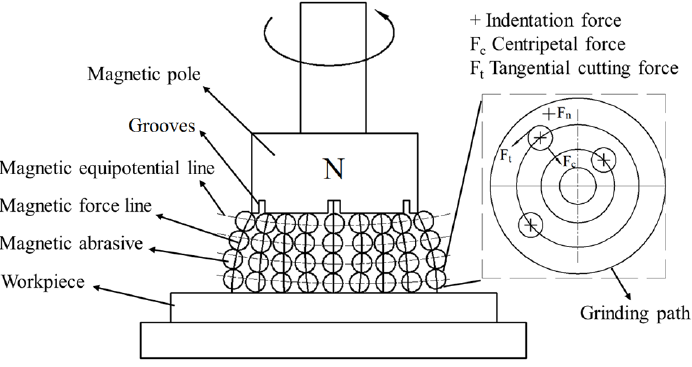
Figure 10. MAF schematic of polishing planar workpiece.